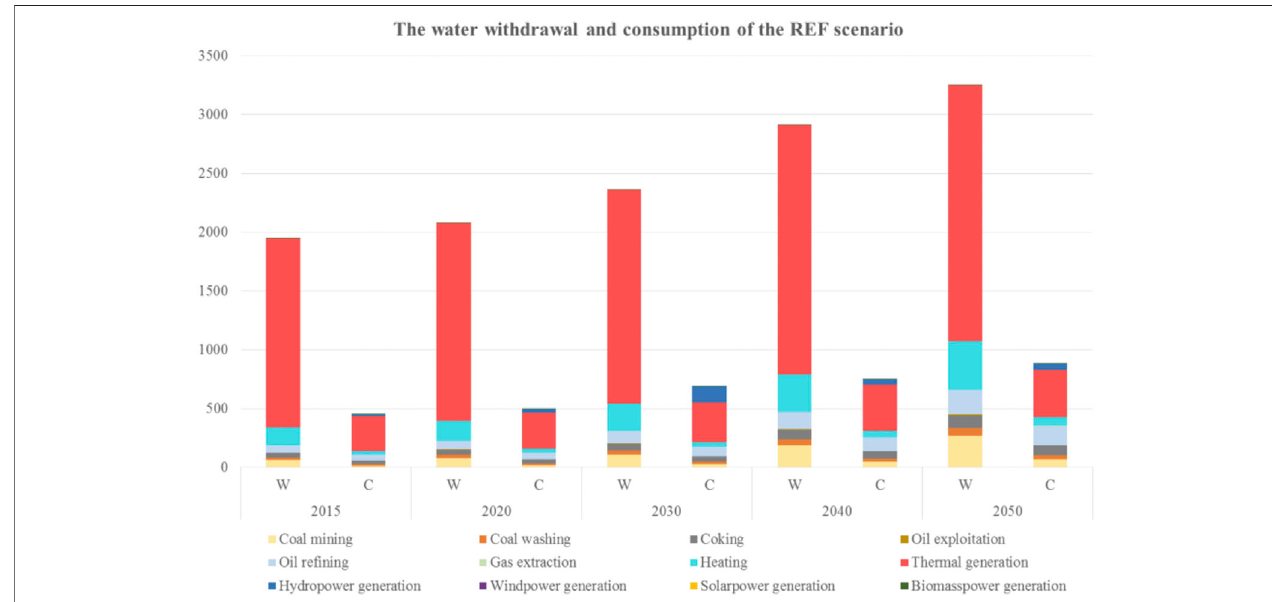
FIGURE 5 | The water withdrawal and water consumption of each sector in the reference (REF) scenario. Note: W represents water withdrawal, and C represents water consumption.